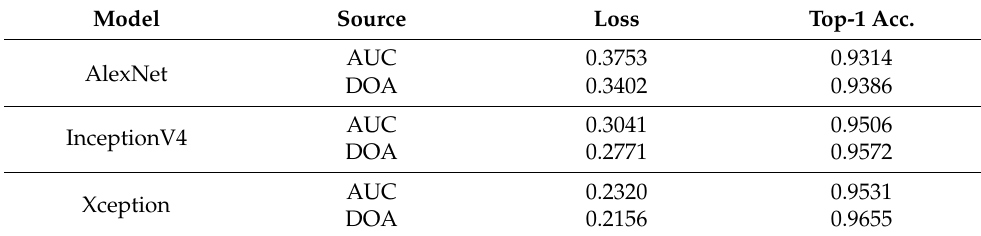
Table 2. Image classification test result with AUC and DOA dataset.